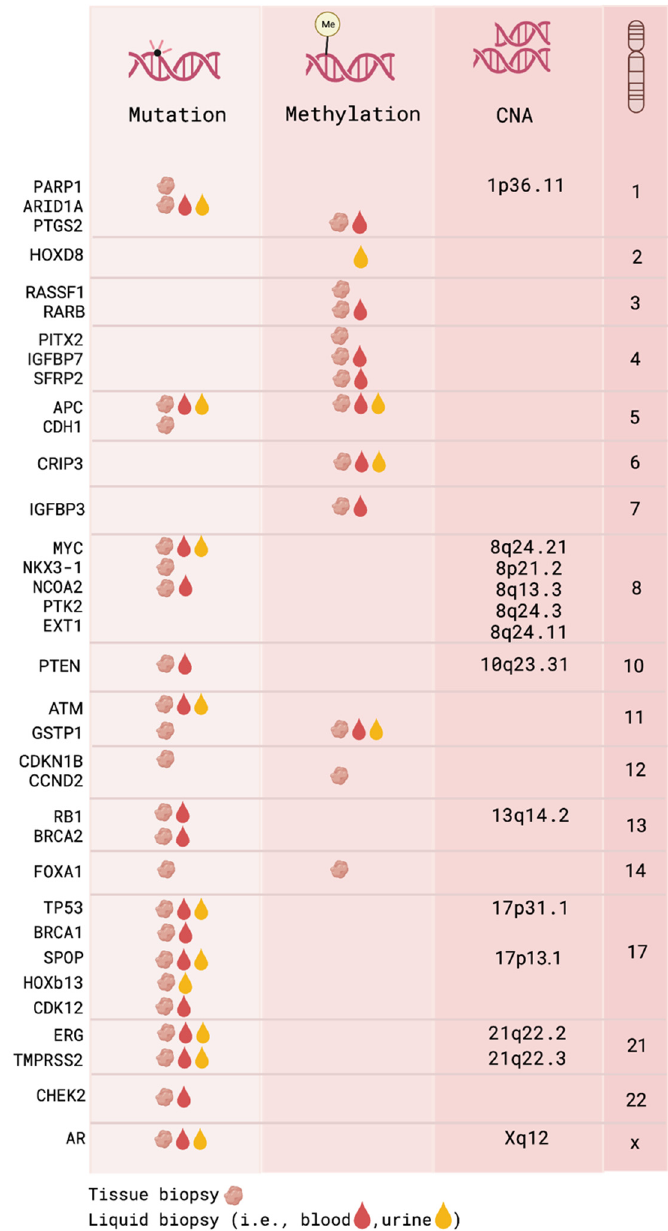
Figure 2. Common genomic and epigenomic instabilities detected in tissue, blood, and urine of PCa patients [17,29,35,39,55,56]. Created with BioRender.com.